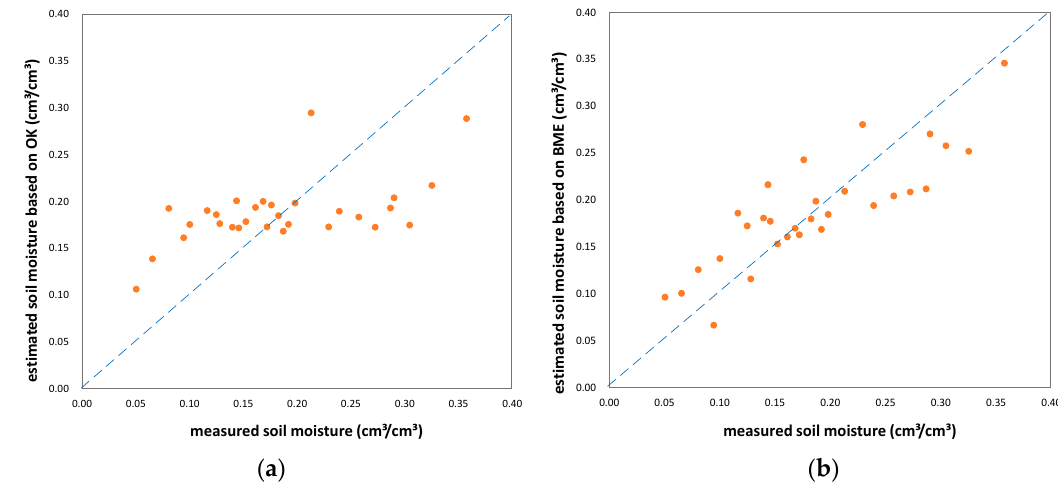
Figure 8. Scatter plots between the measured and estimated soil moisture values obtained using the OK method and BME framework based on 30 independent validation datasets. A 1:1 line is included in the plots. ( a ) OK method, ( b ) BME framework.